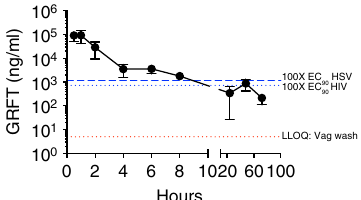
Fig. 5 PK of GRFT in vaginal washes of DMPA-treated mice. Vaginal washes were collected from 5 – 6 mice per time point at 0.5, 1, 2, 4, 6, 8, 24, 48, and 72 h after FDI insertion. Separate mice were measured at each time point. The levels of GRFT equivalent to 100-fold above the anti-HIV EC 90 and 100-fold above the anti-HSV-2 EC 90 are both shown (blue dotted lines) as is the LLOQ of GRFT (red dotted line) in mouse vaginal washes (5 ng/ ml). Each symbol with error bars indicates the mean ± SEM of the mice in that